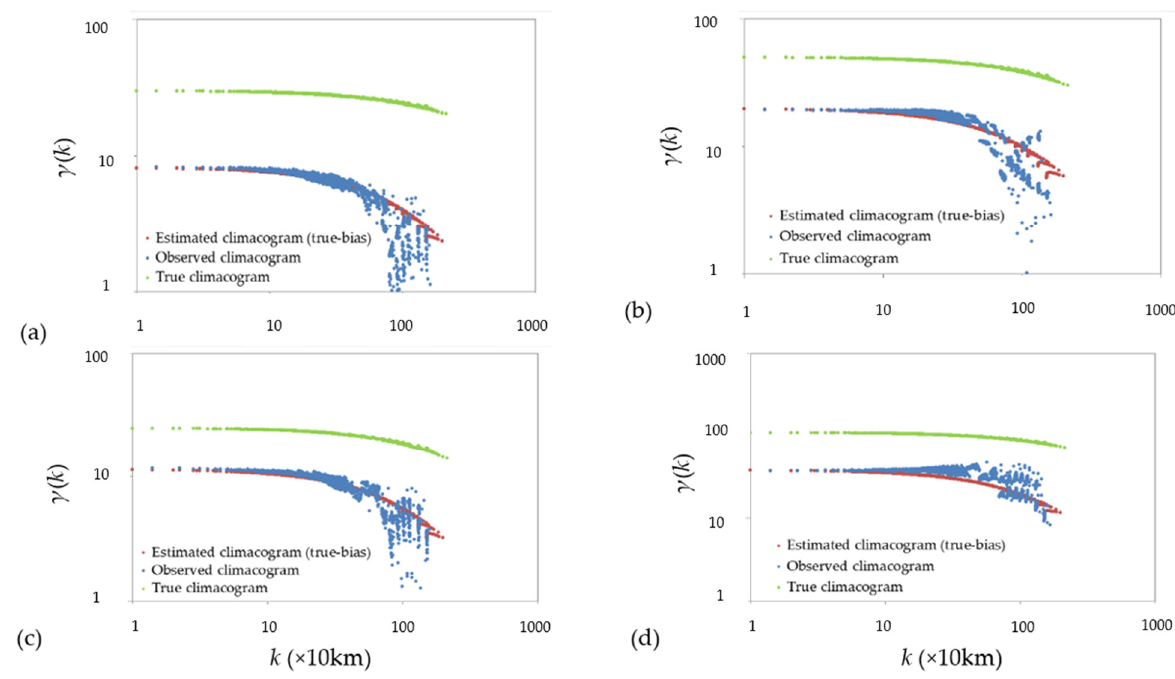
Figure 10. Climacograms (i.e., aggregated variance of brightness vs. spatial scale in units k × 10 km) for the ( a ) 23rd, ( b ) 25th, ( c ) 27th and ( d ) 29th day of October 2012. Source: [40].